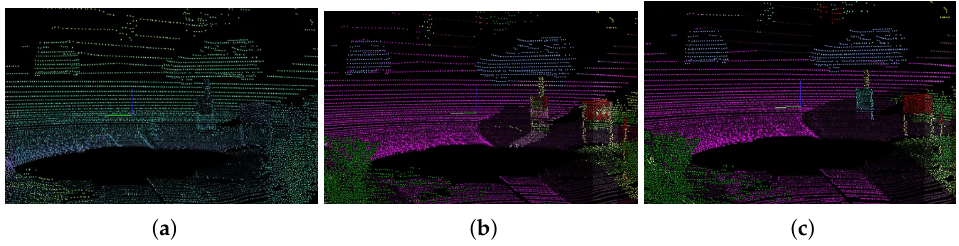
Figure 4. Qualitative results of our semantic segmentation network. ( a ) Input volume; ( b ) segmenta- tion network predictions; ( c ) ground